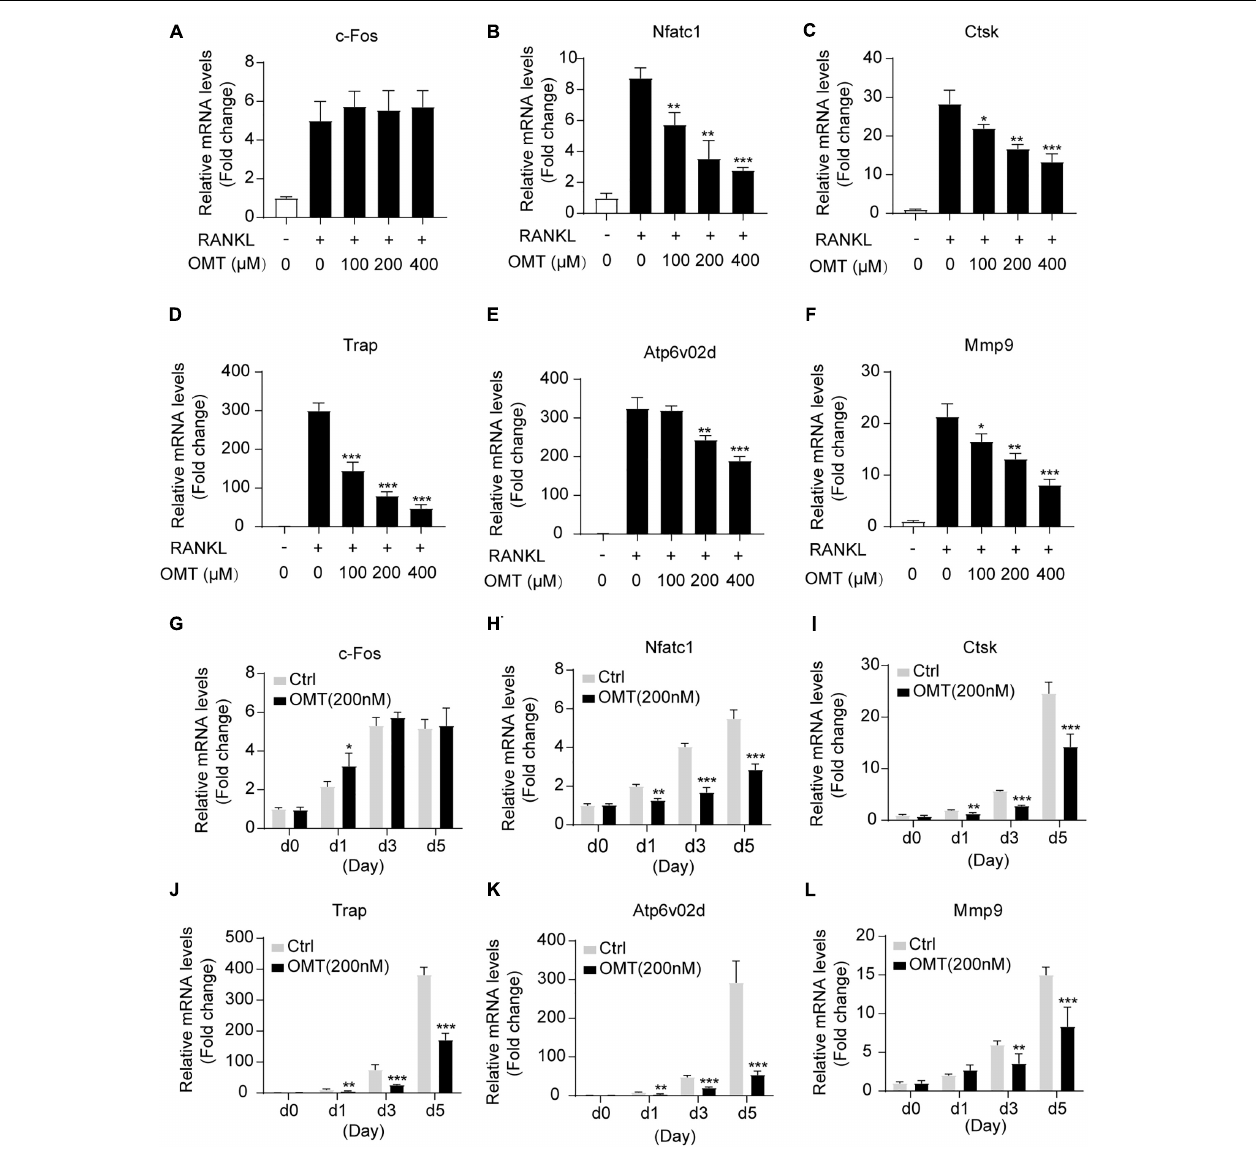
FIGURE 2 | OMT inhibits RANKL-induced osteoclast-specific gene expression in vitro . (A–F) BMMs were treated with M-CSF, RANKL and indicated concentrations of OMT for 5 days, the expression of c-fos, Nfatc1, Ctsk, Trap, Atp6v02d, and Mmp9 were analyzed by real-time PCR and normalized relative to Gapdh . (G–L) BMMs were treated with M-CSF, RANKL, and 200 µ M OMT for 0, 1, 3, 5 days, the expression of osteoclast-specific genes was tested. Data were presented as means ± SD of 5 independent experiments. * p < 0.05, ** p < 0.01, *** p < 0.001.